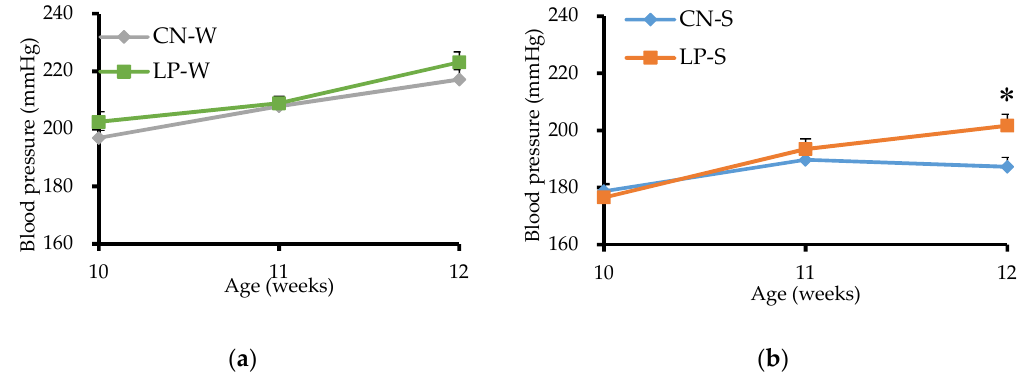
Figure 1. Effect of low protein intake during pregnancy on the blood pressure of offspring. Blood pressure changes from 10 to 12 weeks after birth in ( a ) CN-W and LP-W (Animal Experiment 1), and ( b ) CN-S and LP-S (Animal experiment 2) offspring. Values are expressed as the mean ± standard error ( n = 7–8). * p < 0.05 vs. the CN-S group, according to a Student’s t -test. Offspring were exposed to either an intrauterine environment of 20% (CN)-feeding mothers or that of 9% (LP)-Casein diet-feeding mothers, and provided with either water (W) or 1% saline drinking supply (S).